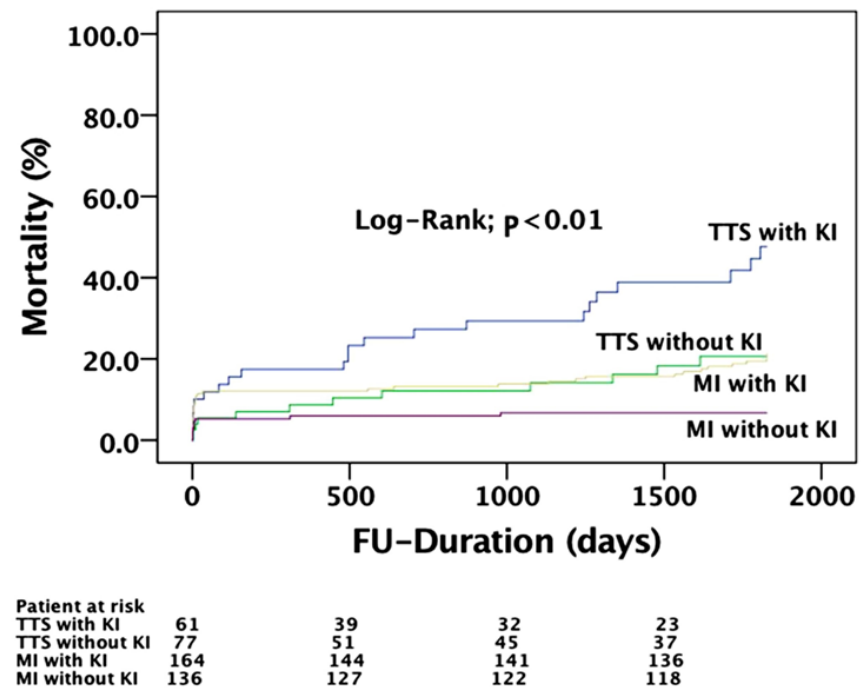
Figure 3. Mortality rate in patients suffering from takotsubo cardiomyopathy (TTS) and KF compared to patients with NTEMI, STEMI, and kidney failure at five-year follow-up.